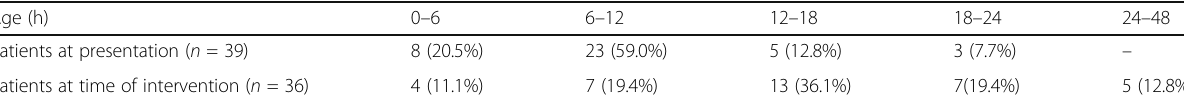
Table 1 Age of patients at presentation and at intervention Age (h) Patients at presentation ( n = 39) Patients at time of intervention ( n = 36)